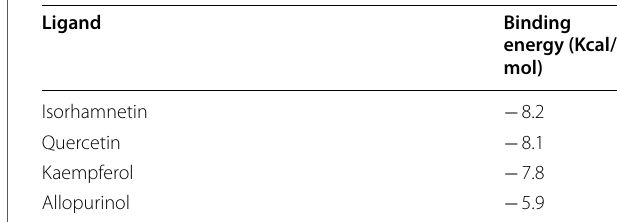
Table 2 Binding energies (in Kcal/mol) of allopurinol and